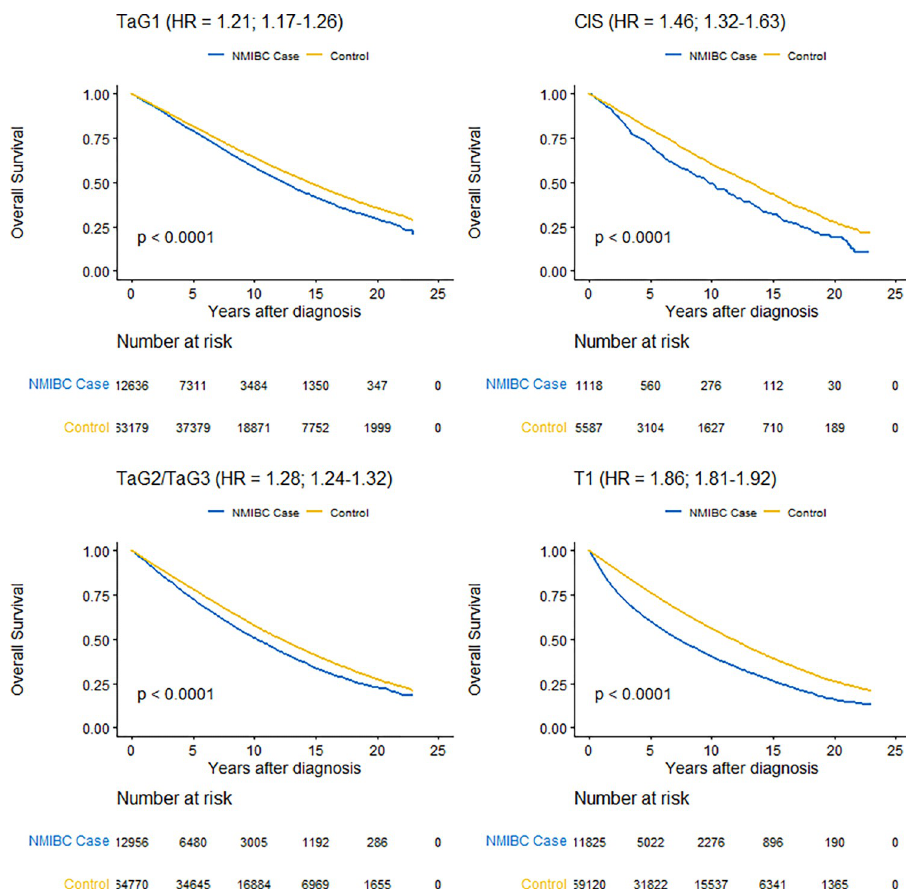
Fig 1. Kaplan-Meier estimates of overall survival in the non-muscle invasive bladder cancer cohort (NMIBC) by prognostic group compared to their respective matched comparison cohorts with log-rank test of statistical significance and unadjusted hazard ratio (HR) with 95% confidence interval from a Cox proportional hazards model.